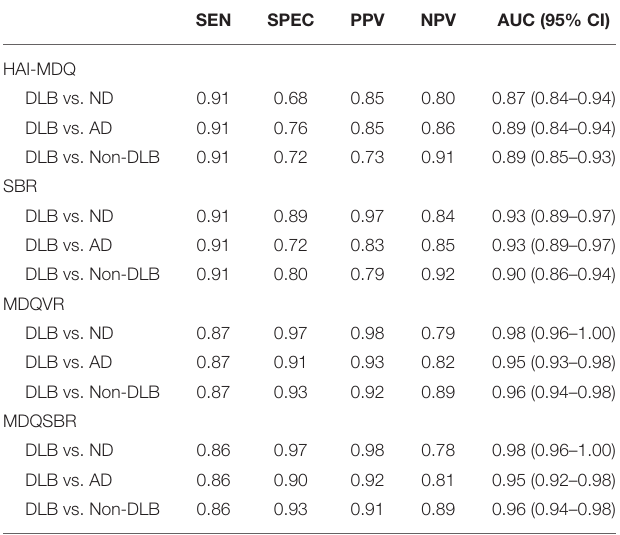
TABLE 2 | Comparison of SEN, SPEC, PPV, NPV, and AUC with 95% CI among the DLB vs. ND, DLB vs. AD, and DLB vs. non-DLB groups using a cutoff score of 3/2 for the HAI-MDQ, a cutoff score of 1.37/1.38 for the SBR, and a cutoff score of 6/5 for the combination of the MDQVR or